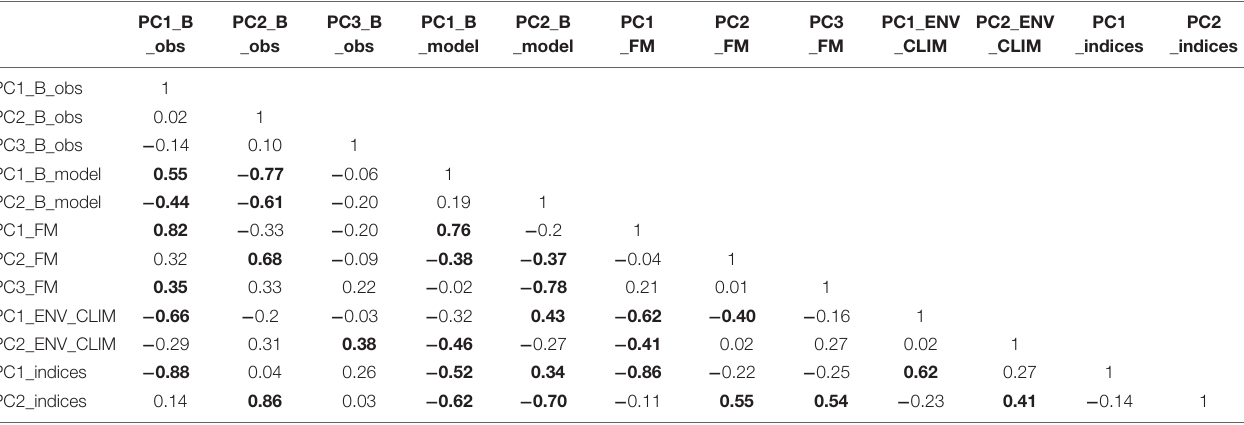
TABLE 5 | Spearman cross-correlation between PCs extracted from different groups of